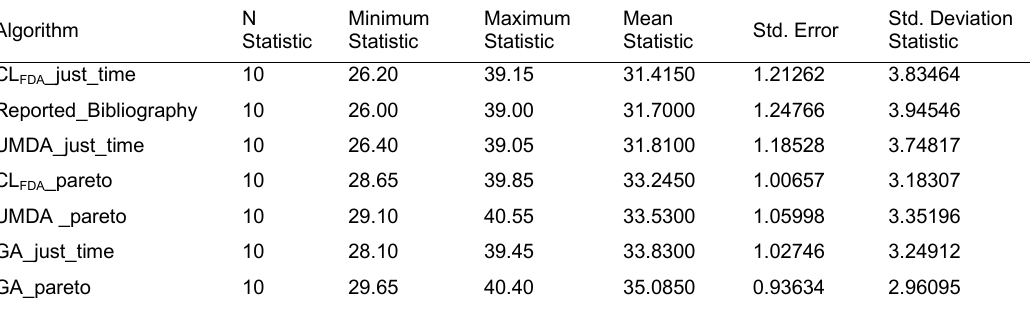
Table 1. Descriptive analysis, variable Mean_Makespan for j30_17 dataset